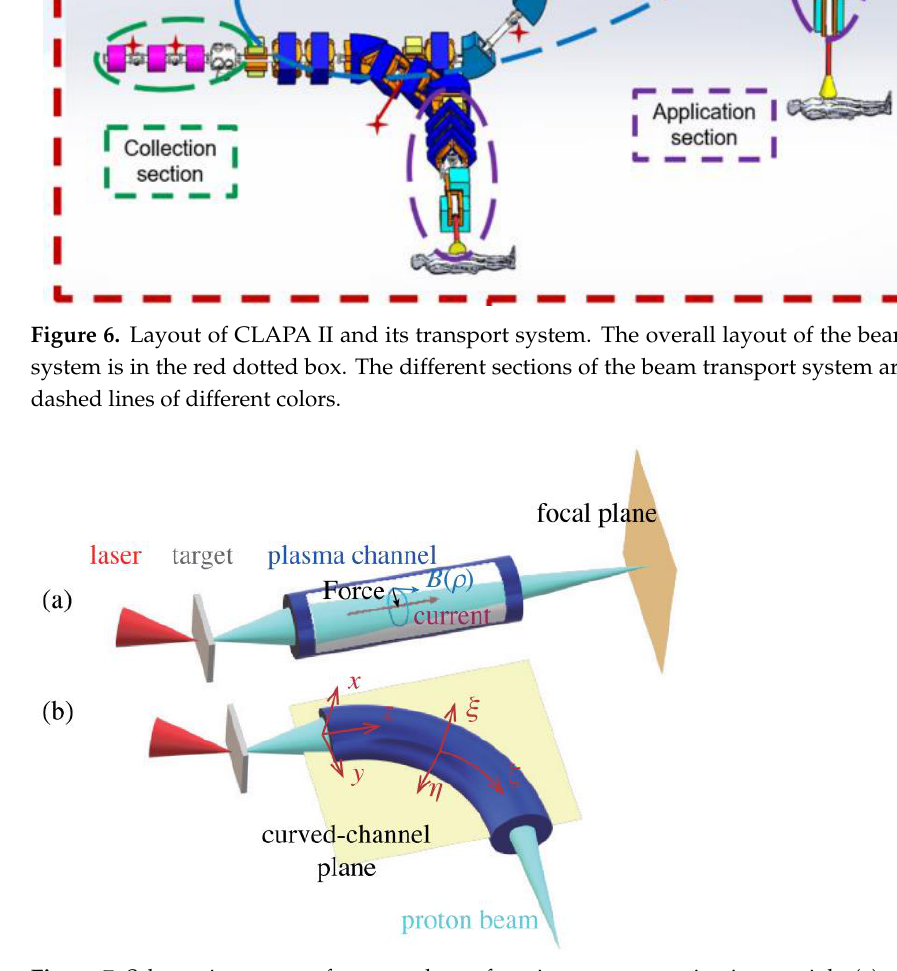
Figure 7. Schematic concept of a proton beam focusing on propagating in a straight ( a ) and a curved ( b ) APL. ( b )